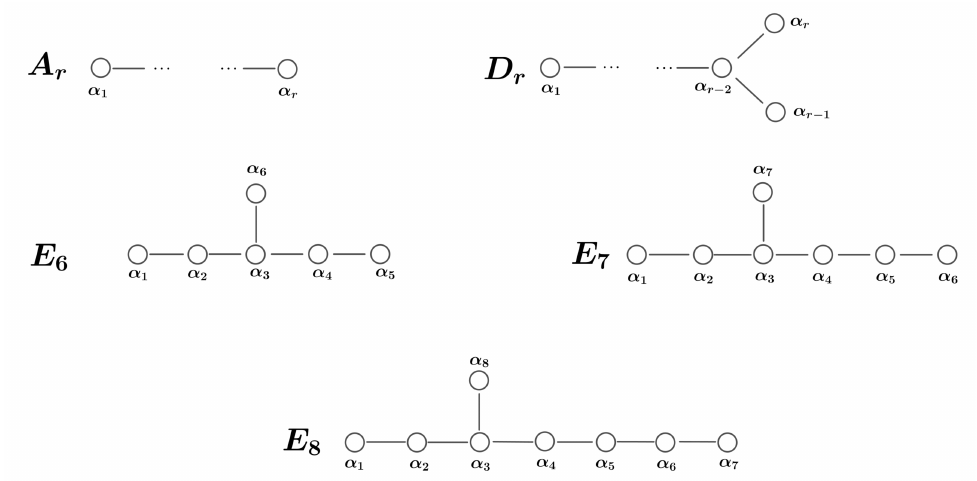
Figure 14 . Roots labelling